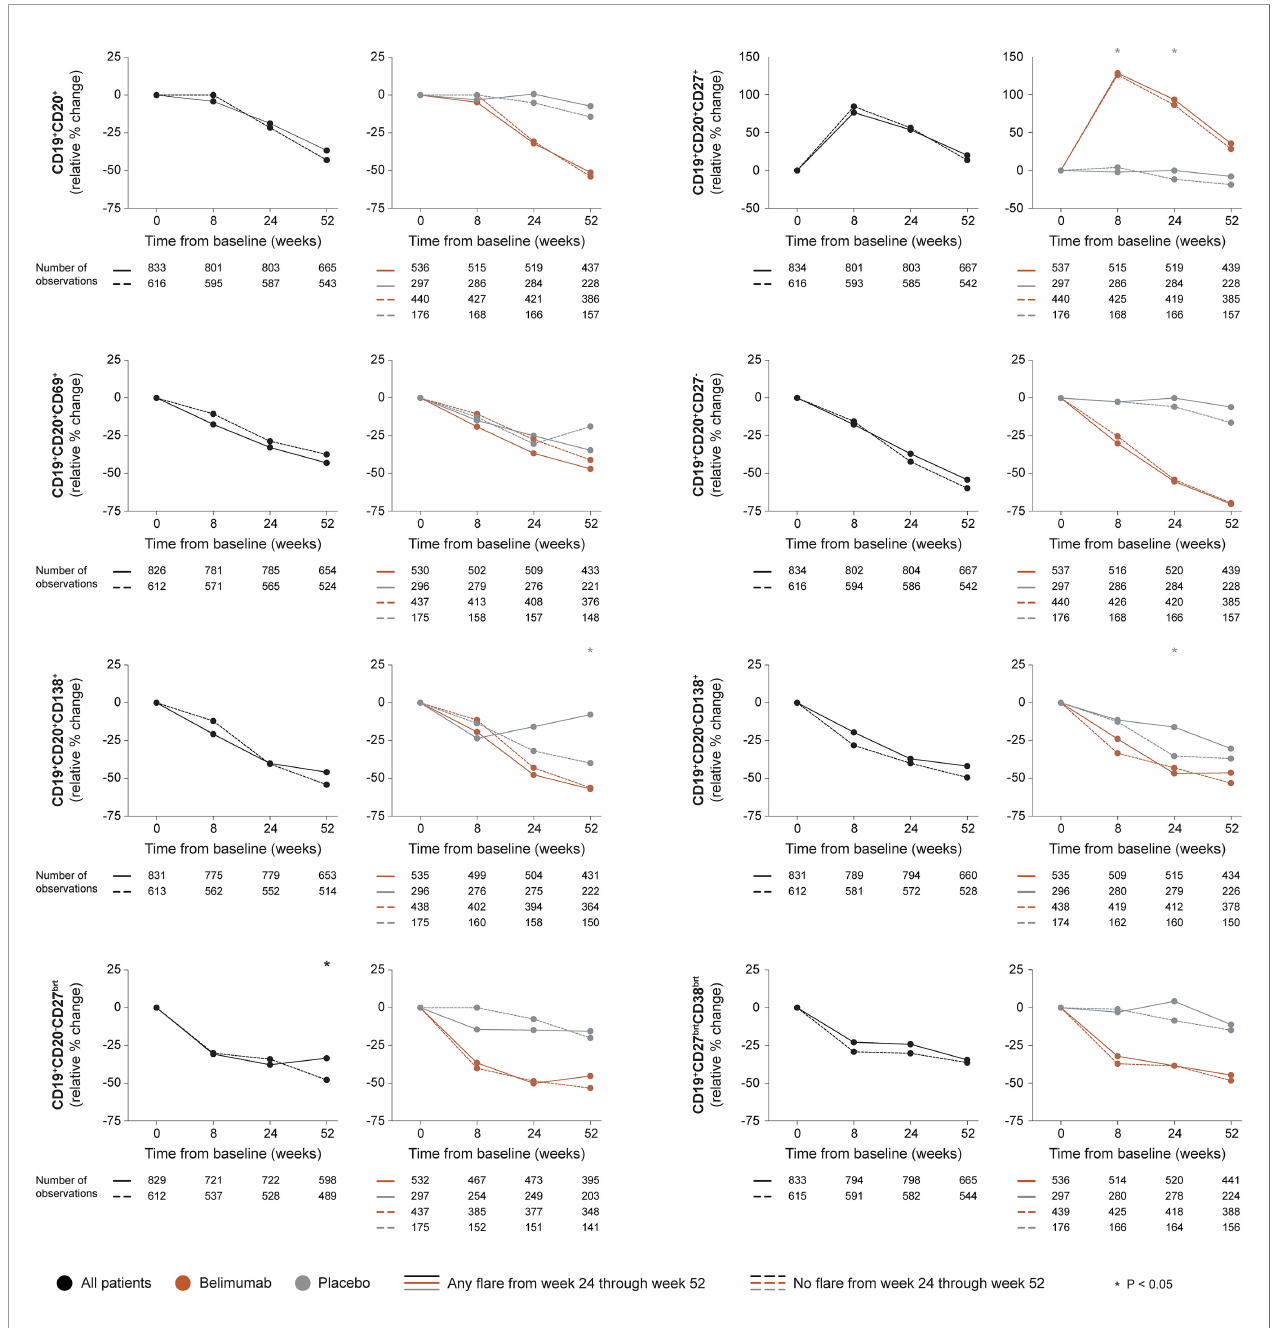
FIGURE 1 | B cell alterations in relation to fl ares occurring from week 24 through week 52. The graphs delineate relative to baseline percentage changes in selected B cell and plasma cell subsets from baseline through different time points in patients who developed at least one SFI fl are (mild/moderate or severe) from week 24 through week 52 (continuous lines) and patients who did not (dashed lines). Comparisons between patients who fl ared and patients who did not were conducted for the entire population with available data (black lines), and after strati fi cation into patients who received standard therapy plus belimumab (terracotta lines) and patients who received standard therapy alone (grey lines). P values derived from non-parametric Mann-Whitney U tests. The number of patients with available data at each time point is indicated for each patient subgroup. SFI, Safety of Estrogens in Lupus Erythematosus National Assessment (SELENA) - Systemic Lupus Erythematosus Disease Activity Index (SLEDAI) Flare